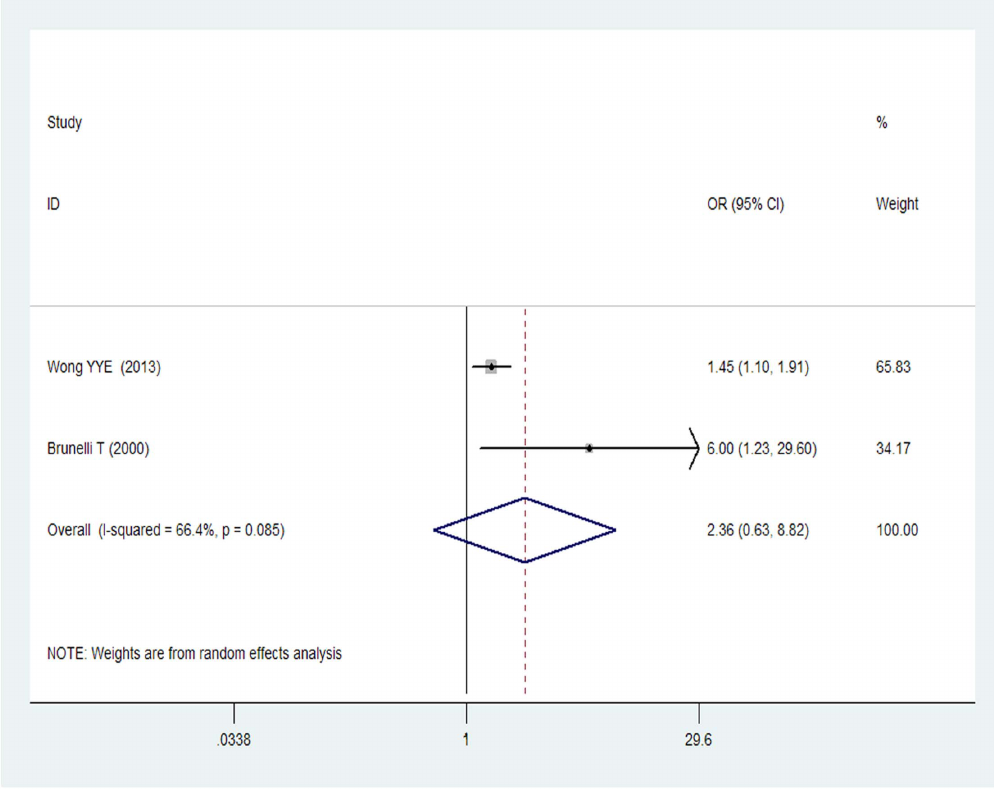
Figure 5. OR and 95% CI from the included studies of plasma Hcy level and AAA by men.